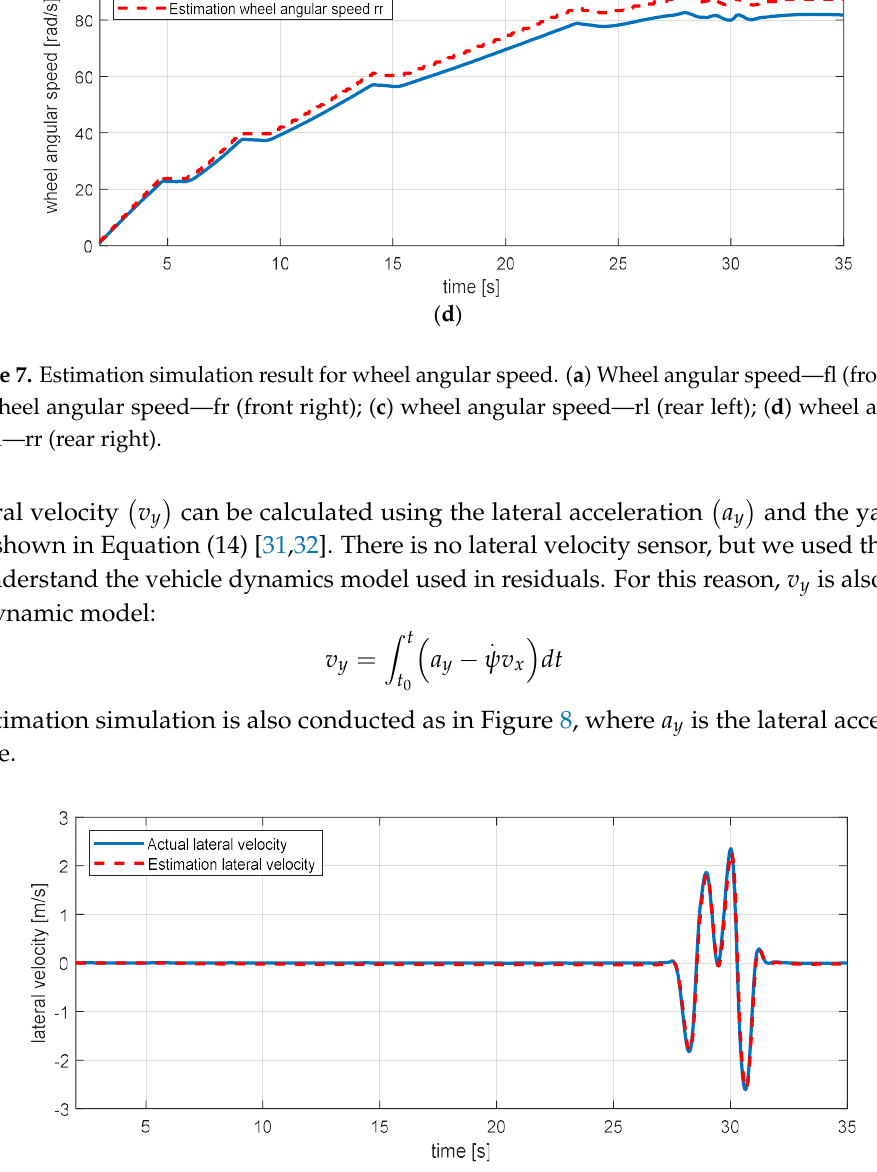
Figure 8. Estimation simulation result for lateral velocity.